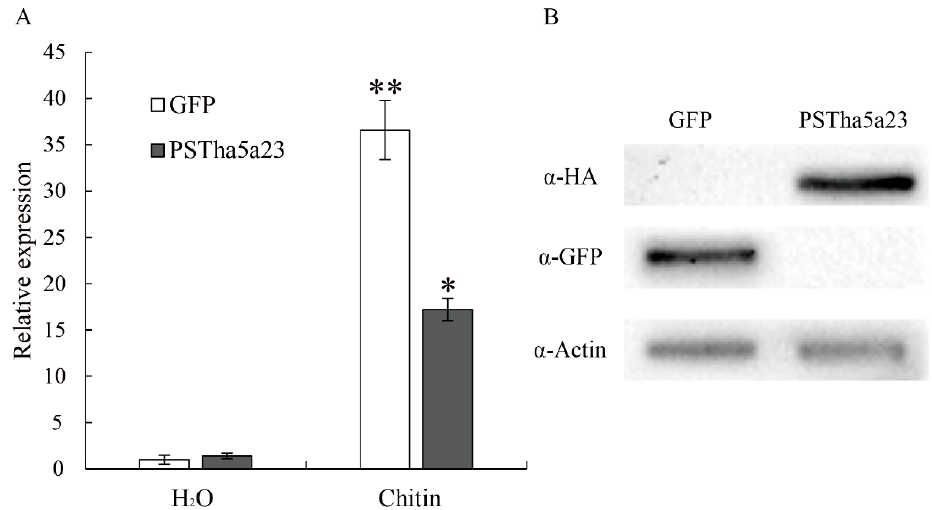
Figure 5. Expression of PSTHa5a23 in wheat inhibits PAMP-triggered immunity (PTI). ( A ) Transient expression of PSTHa5a23 inhibits chitin-induced TaPr-1-14 expression in wheat protoplasts. The wheat protoplasts isolated from wheat cultivar CN19 were transfected with pHBT95-35S-GFP (GFP) or pHBT95-35S-PSTha5a23-HAHA (PSTha5a23) vector, induced with 100 μ g/mL Chitin for 4 h. The relative expression of TaPr-1-14 was determined by using the comparative threshold ((2 − ∆∆ CT ) method, and values are expressed relative to an endogenous wheat reference gene TaActin . Values were normalized to an internal H 2 O/GFP control. ( B ) Immunoblot analyses of PSTha5a23-HAHA and GFP proteins obtained from the wheat protoplasts. Each data point represents four replicates. Error bars indicate SD. Student’s t -test was carried out to determine the significance. *, p < 0.05; **, p < 0.01.